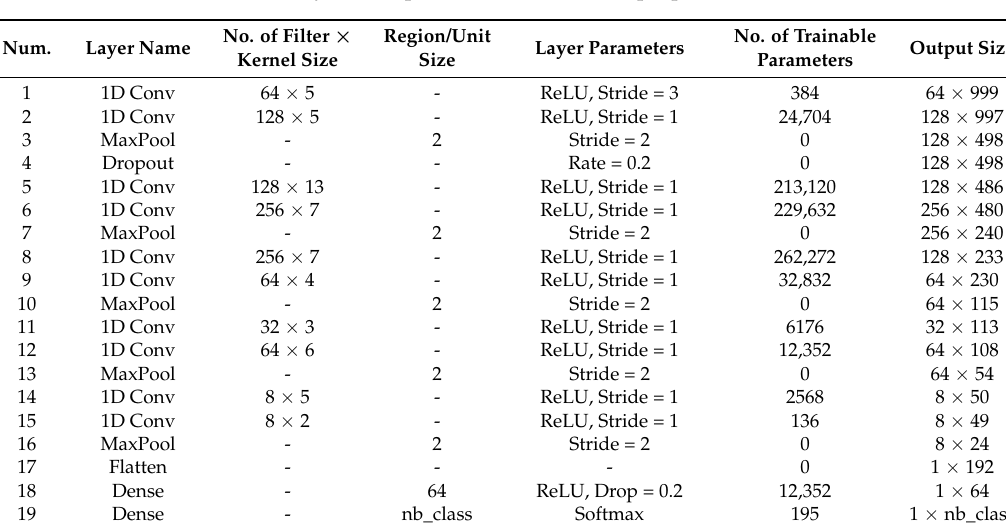
Figure 2. Block representation of the proposed one-dimensional convolutional neural network (1D-CNN)